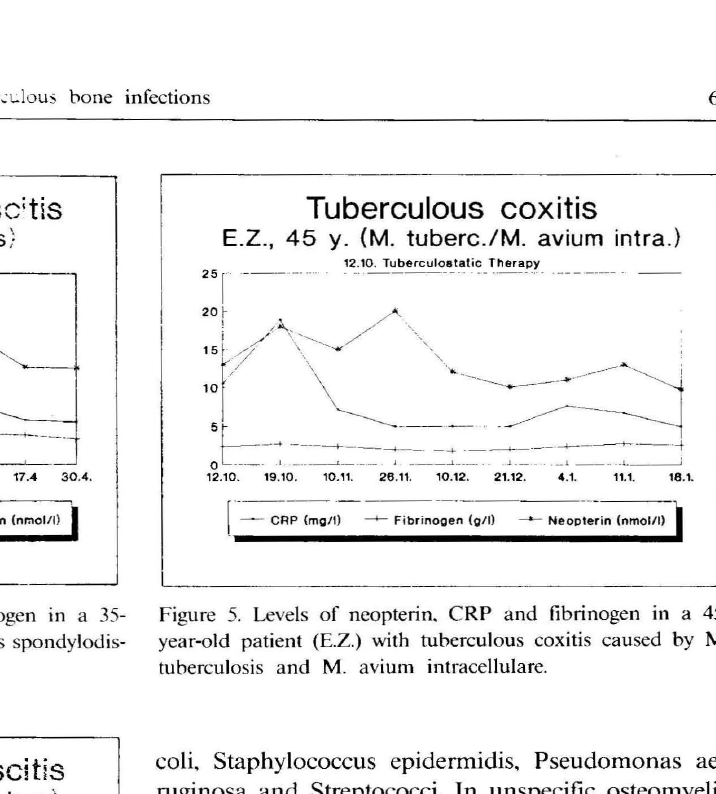
Figure 5. Levels of neopterin. CRP and fibrinogen in a 45- year-old patient (EZ.) with tuberculous coxitis caused by M. tuberculosis and M. avium